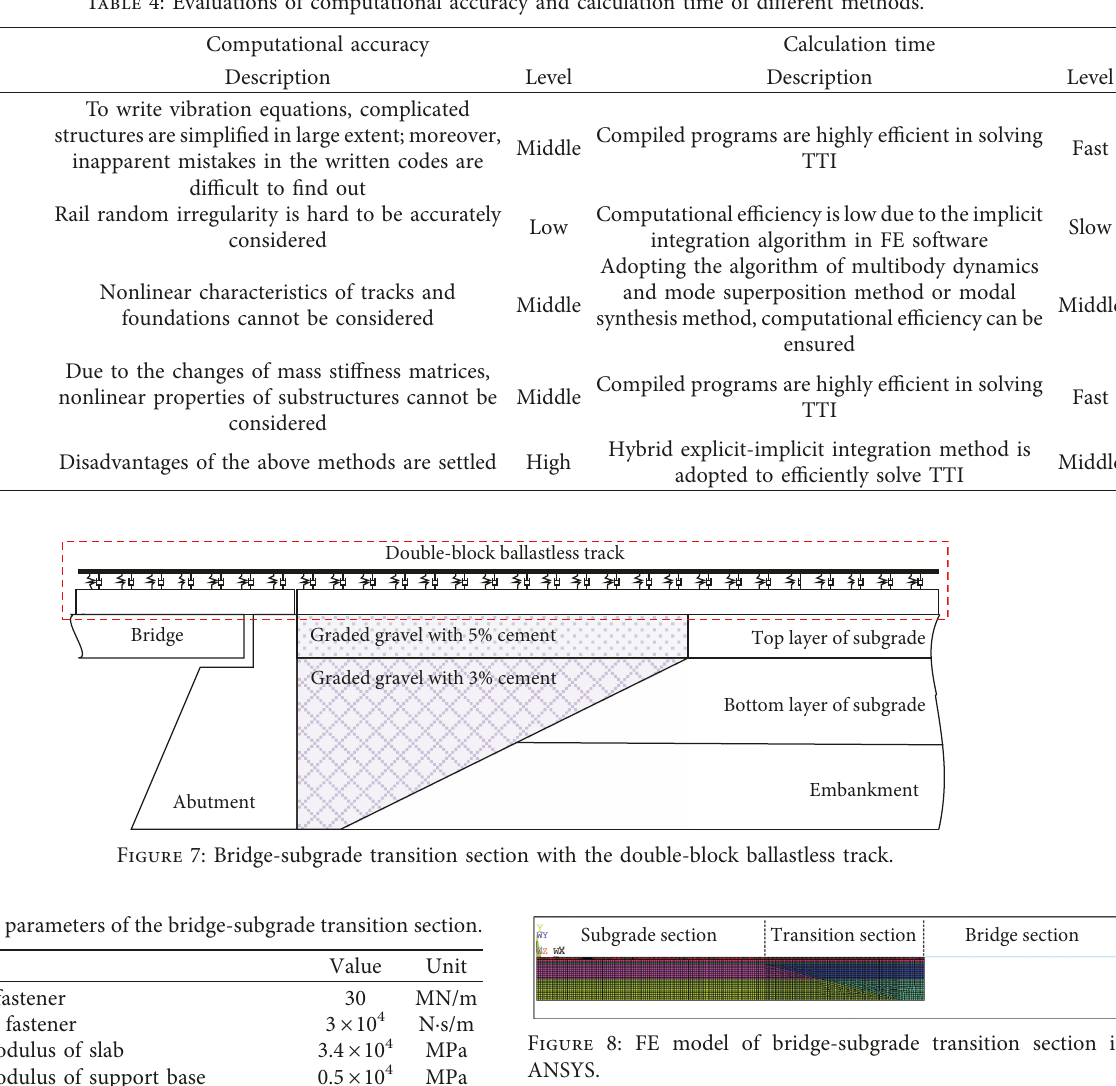
Table 4: Evaluations of computational accuracy and calculation time of different methods.